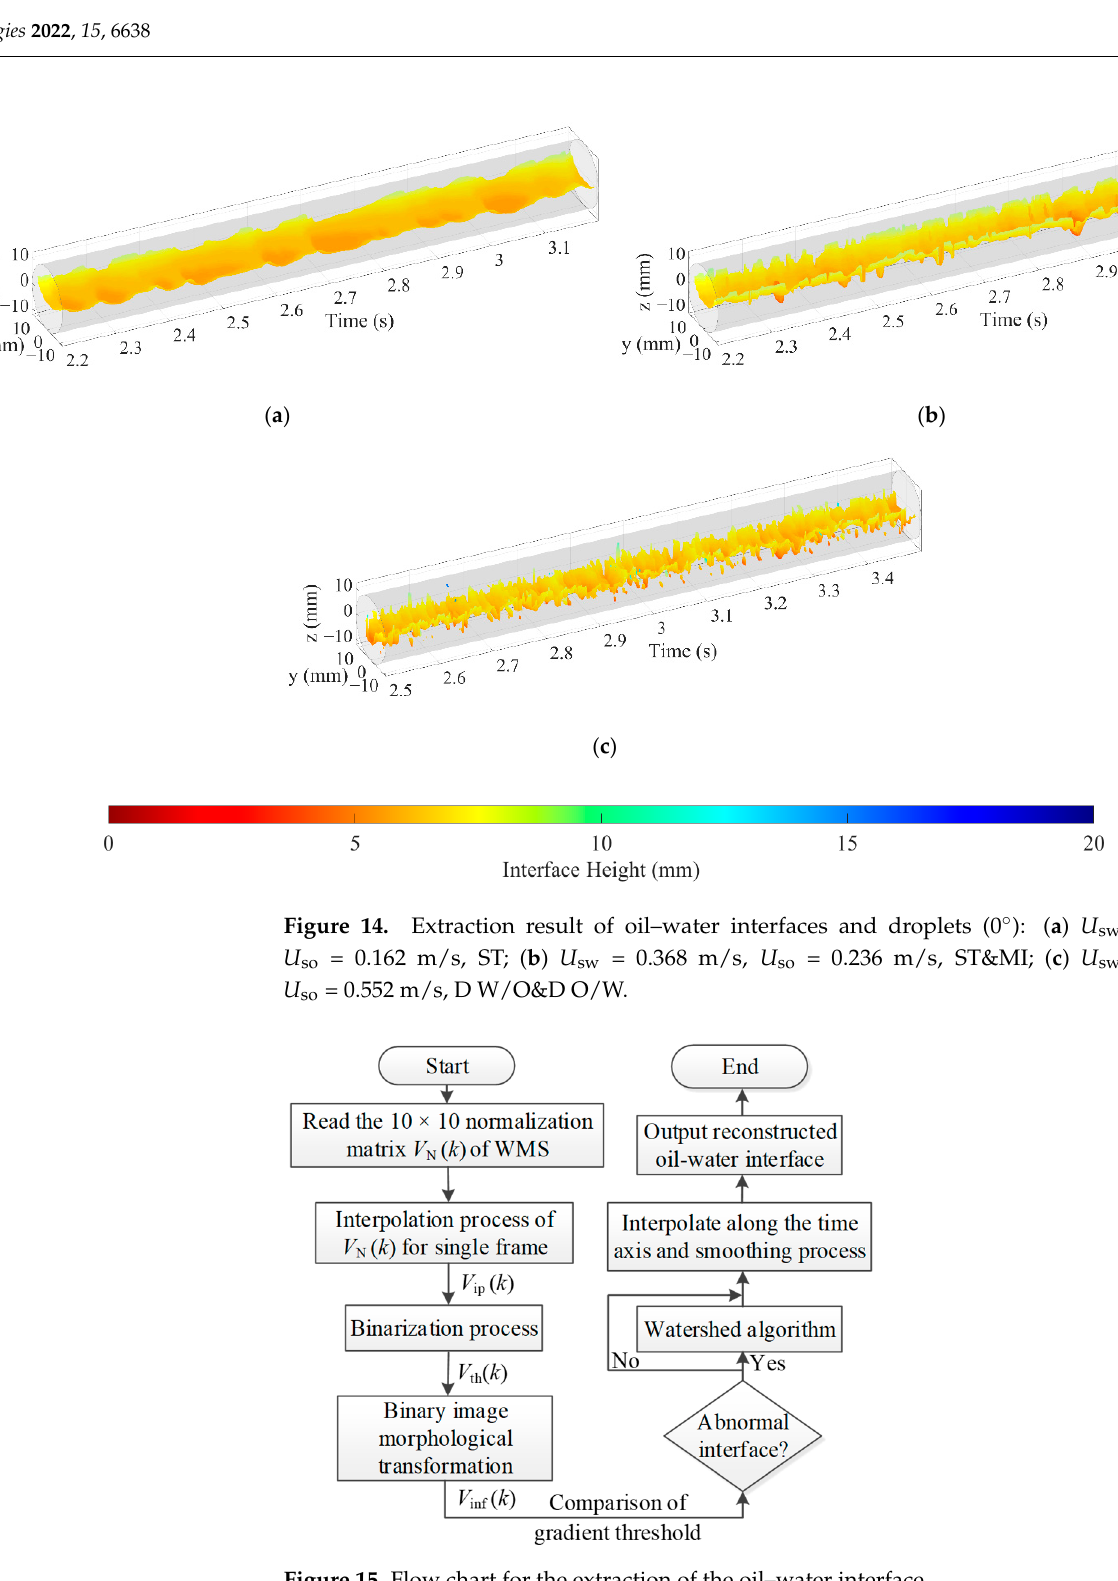
Figure 16. Extraction process of 2D oil–water interface: ( a ) Interpolation matrix V ip ( k ); ( b ) Binariza ‐ tion processes ( V th ( k )); ( c ) Remove dispersed droplets ( V inf ( k )); ( d ) Interface extraction using water ‐ shed algorithm.